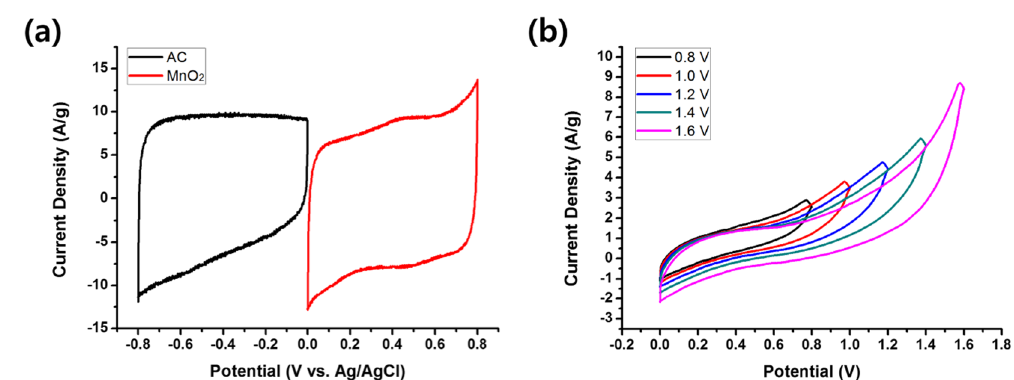
Figure 7. Characterization of asymmetric AC//MnO 2 two-electrode supercapacitor. Cyclic voltammograms of ( a ) individual AC and MnO 2 electrode measured in a three-electrode system at a scan rate of 20 mV s − 1 and ( b ) asymmetric AC//MnO 2 supercapacitors measured at a scan rate of 20 mV s − 1 with various potential